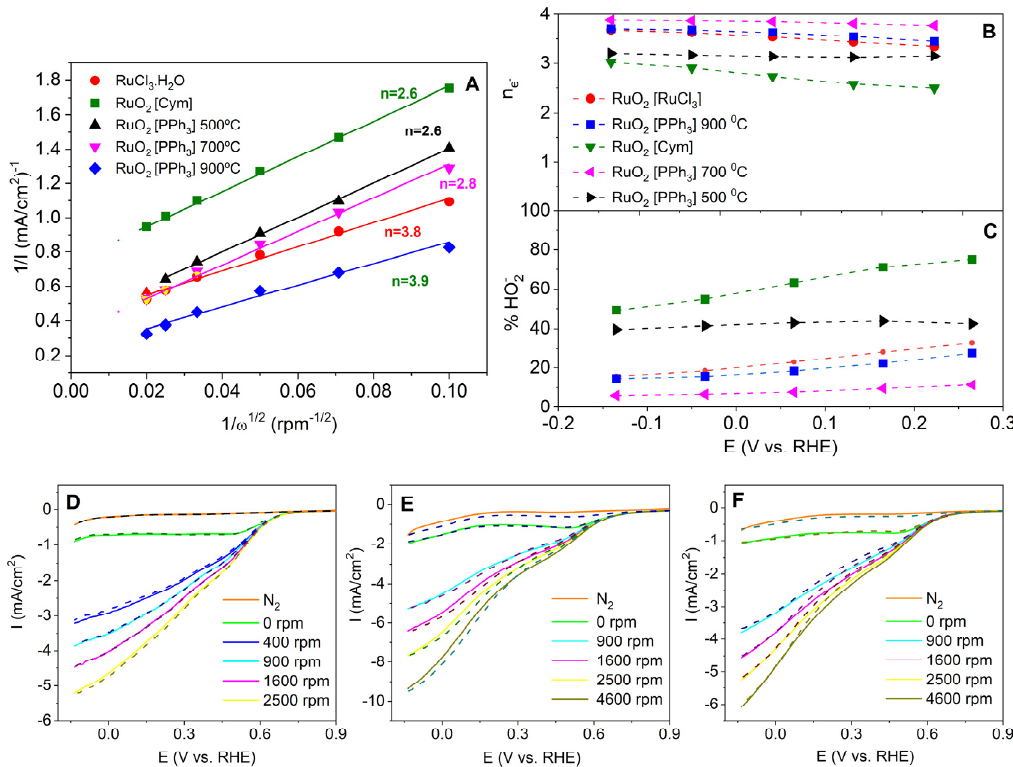
Figure 7. ( A ) KL plots for the different materials at − 0.6 V (vs. Hg/HgO), including the n value obtained at this potential. ( B ) Dependence of the electron transfer number and ( C ) the HO 2 − values with electrode potential at 1600 rpm from data in Figure 5 using Equations (S.3) and (S.4). A complete set of plots showing the KL plots, n, and the HO 2 − values at different potentials for all materials can be found in the supplementary materials file (Figures S7 and S8). LSV results obtained before and after 1000 voltametric cycles (0.265–0.865 V vs. RHE) for ( D ) RuO 2 [PPh 3 ], ( E ) RuO 2 [RuCl 3 ] and ( F ) RuO 2 [Cym] in an O 2 –saturated KOH 0.1 M solution at different rotations.